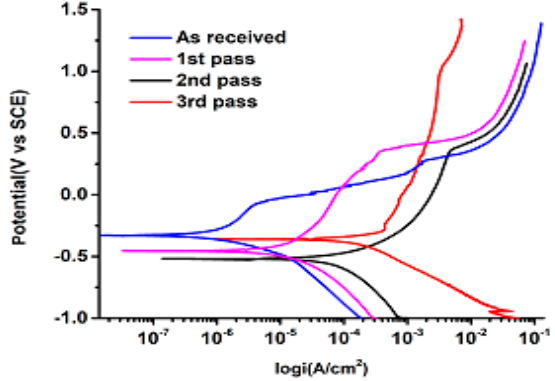
Figure 3. Potentiodynamic polarization curve of the Al5083 alloy in the 3.5% NaCl solution.